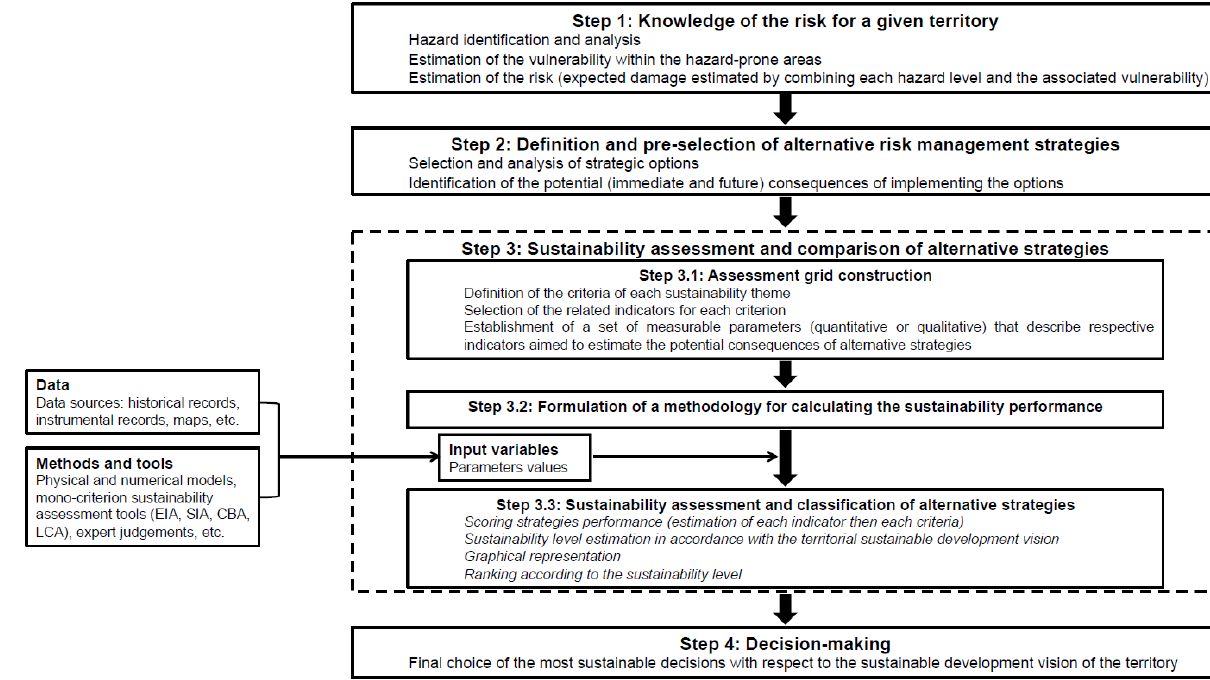
Figure 1. Theoretical overview of the decision-making process for sustainable risk management (source: